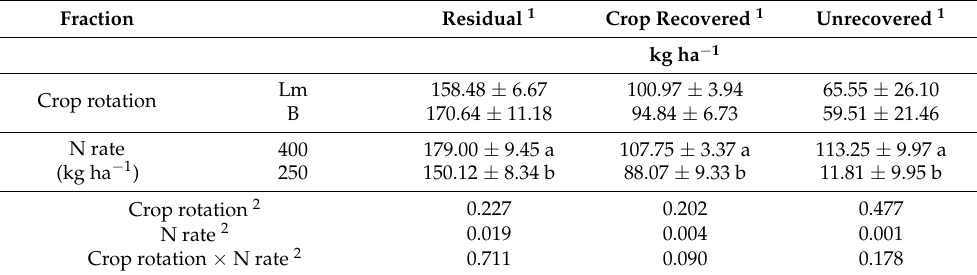
Table 8. Nitrogen recovered in the soil (residual), in the maize crop, or unrecovered by the end of the growing